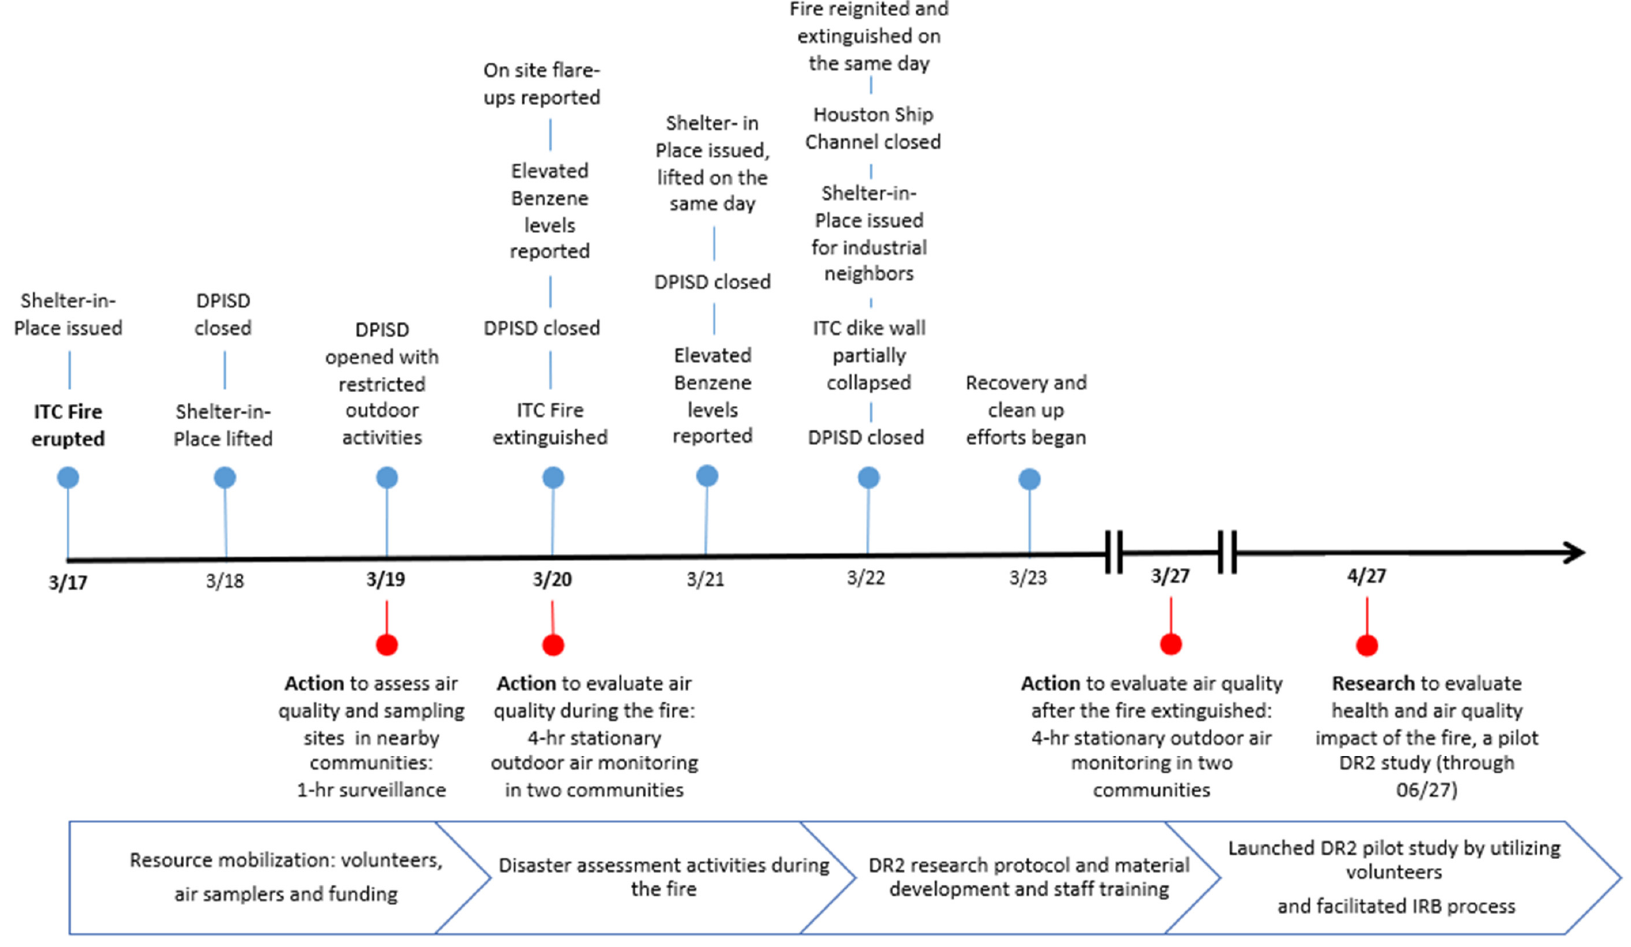
Figure 1. Timeline of ITC fire and action to research disaster response mechanisms. DPISD: Deer Park Independent School District; DeeP Fire Study: Deer Park Chemical Fire Study; ITC: Intercontinental Terminals Chemical; and DR2: disaster research response.